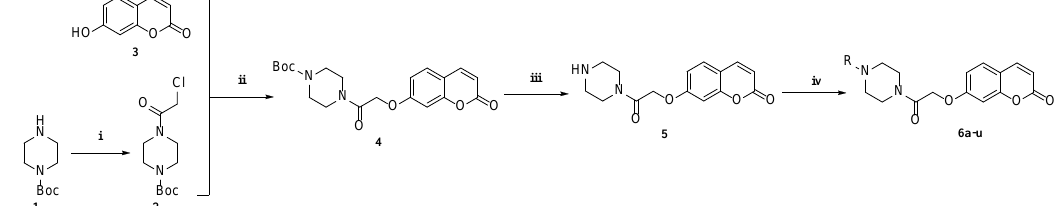
Table 1. Antidepressant activities of compounds 6a–u in